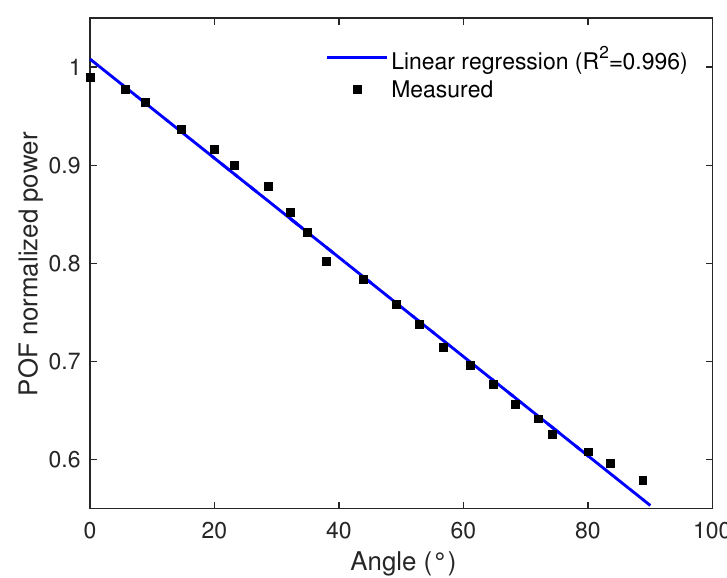
Figure 9. Sensors’ placement on the human upper limb and the movements performed.